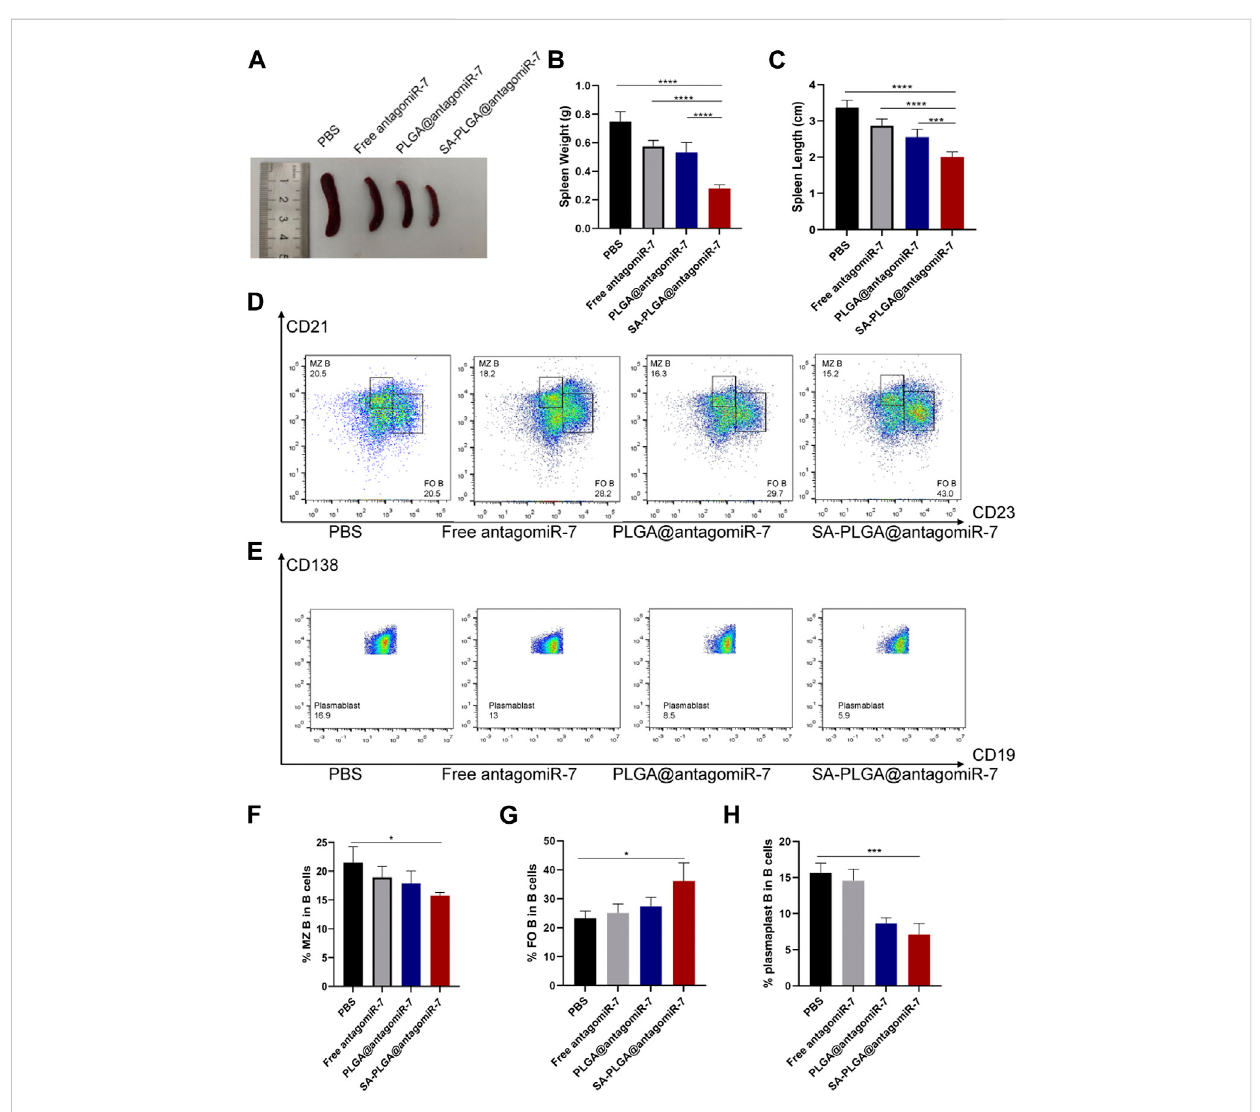
FIGURE 5 (A) Representative spleen images from SLE mice treated with PBS, Free antagomiR-7, PLGA@antagomiR-7, and SA-PLGA@antagomiR-7. (B) Spleen weight and length (C) of mice in different treatment groups. (D) Flow cytometry analyzed MZ B (CD21 high CD23 low ) and FO B (CD21 mid CD23 high )